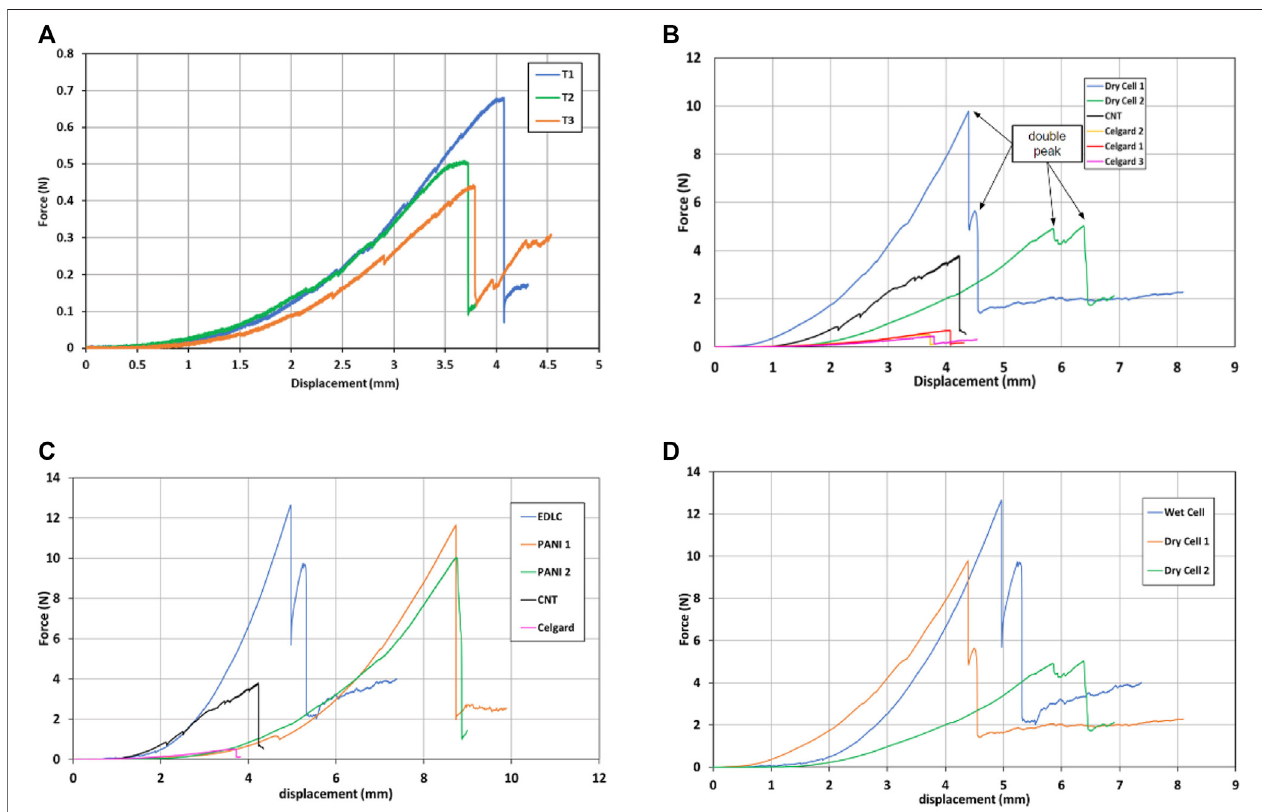
FIGURE 6 | (A) Force-displacement plot for nail penetration of Celgard 2500 separator, (B) Force-displacement plot comparing behavior of Celgard 2500 separator, a dry EDLC cell and a single CNT electrode, (C) Force-displacement plot comparing behavior of the Carbon Nanotube Mat (CNT), Celgard 2500 separator (Celgard), an electrolyte soaked EDLC cell (EDLC) and PANI-coated CNT pseudocapacitor electrode cells (PANI 1 and PANI 2), (D) Force-displacement plot comparing behavior of dry and wet electrolyte soaked cells.